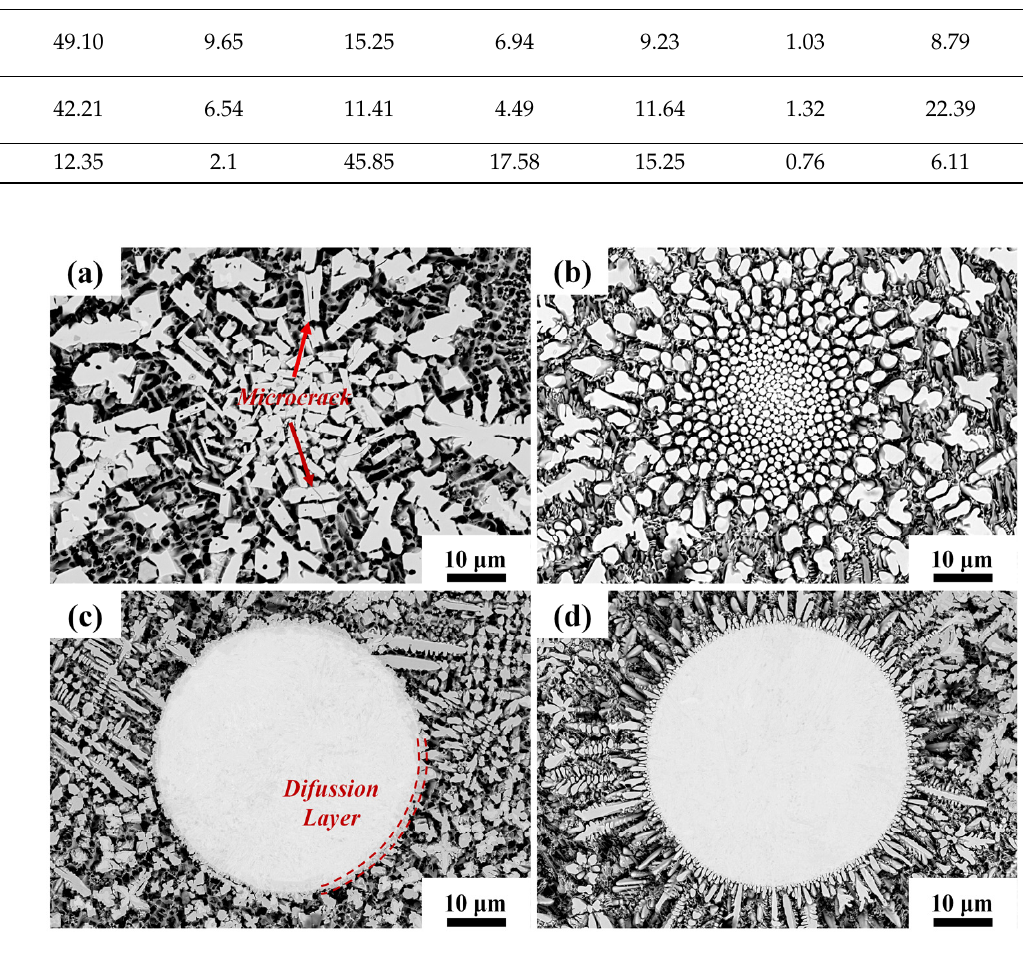
Figure 8. Thermal decomposition characteristics of WC particles during laser cladding process with and without ultrasonic: ( a , b ) disintegration–diffusion type for WC particles with small size; ( c ), ( d ) dissolution–diffusion type for WC particles with large size.